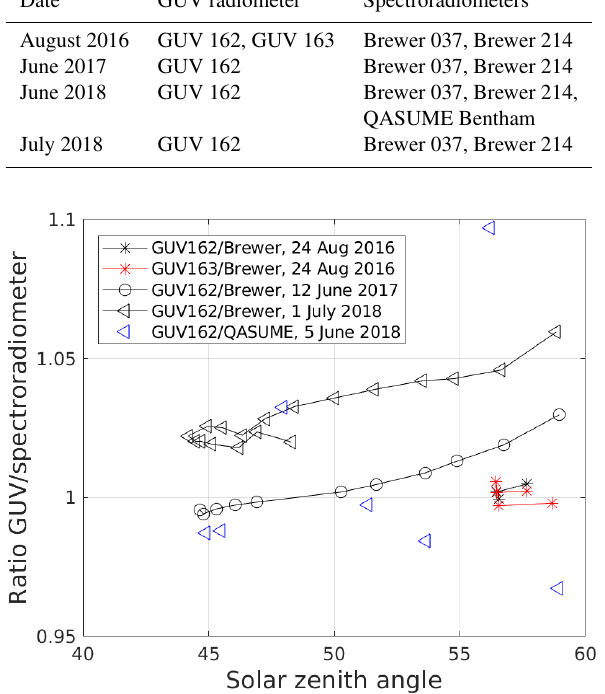
Figure 2. Ratio of the GUV and spectroradiometer UV index at Sodankylä.